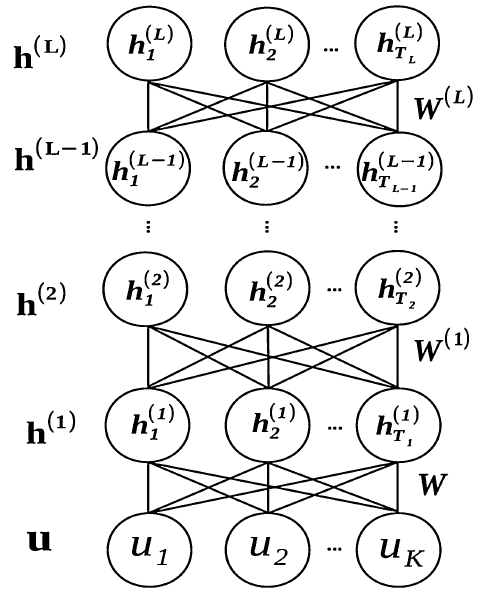
Fig. 4 Graphical representation of deep Boltzmann machine with L hidden layers Fig. 4. There are connections only between adjacent hid- den layer units as well as units in the visible layer and the first hidden layer. Because of the deep hierarchical struc- ture, DBM has greater flexibility and good representation power while modeling complex data distributions. That is,